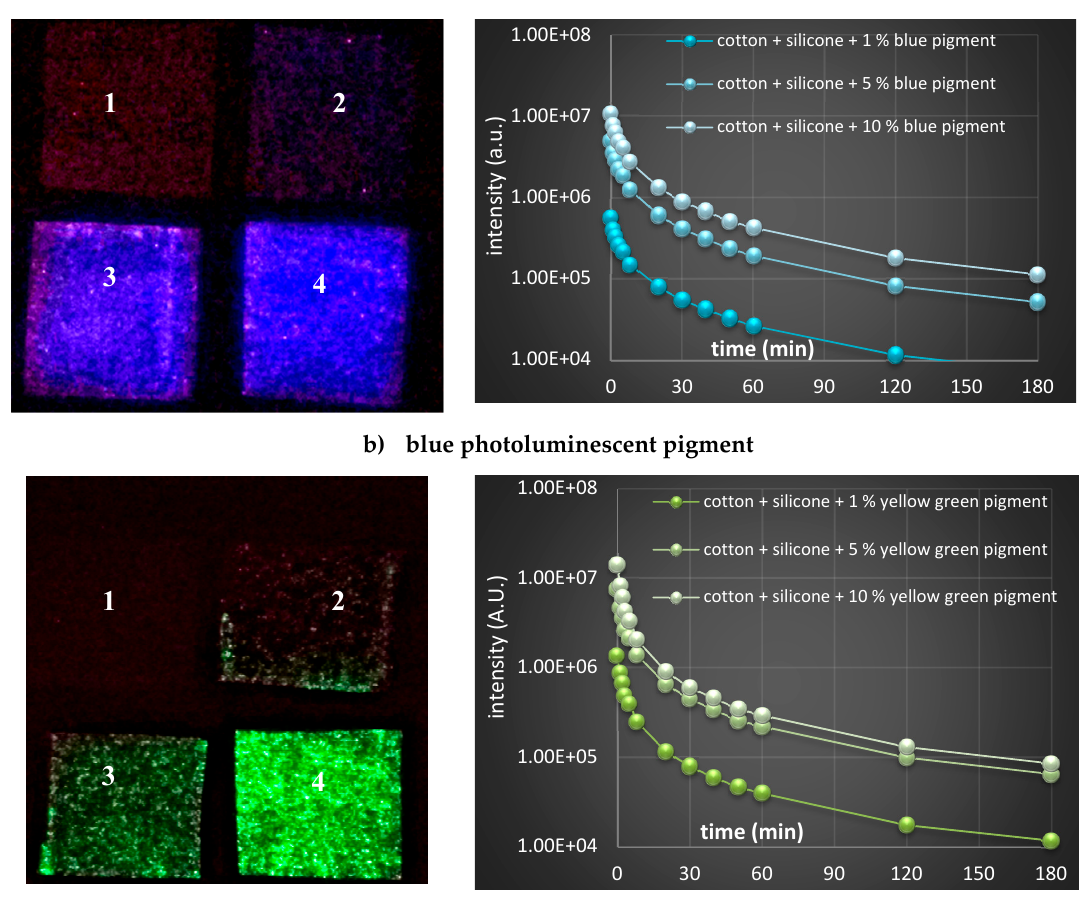
Figure 8. (left) Photographs depicturing differentially printed cotton fabrics, excited within a UV chamber (366 nm) for 5 min. Cotton printed with PDMS (1) 1 wt % (2), 5 wt % (3) and 10 wt % of violet ( a ), blue ( b ) and yellow-green photoluminescent pigment ( c ). (right) Luminescence decay curves were measured for the same samples in a 180 min period (after 1, 2, 3, 5, 8, 20, 30, 40, 50 60, 120 and 180 min). Luminescence curves for the cotton and cotton printed with PDMS without photoluminescent pigments are below the threshold value, i.e., luminescence of the microplate itself. Confocal microscopy was used for the investigation of the distribution of pigments in both the horizontal (xy) and vertical (xz/yz) directions of the cotton fabric, and the results were presented in Figure 9. Confocal microscopy permits depiction and localization of the fluorescing compounds unambiguously at light microscopy resolution [19], offering a non-destructive method for in-depth imaging, without demanding preparation steps. This is due to the point-by-point illumination of samples, and rejection of out of focus light, which enables the 3D imaging [39]. The 3D image is built up by sequential recording of fluorescence emission from a large number of points in a sample in all three dimensions, being achieved by controlled movement of the focus point of the laser beam by mirrors, and by moving the sample in the third dimension by automated stage [40]. The same imaging parameters were applied for both pigments and printed cotton fabrics. Under specified excitation conditions ( λ ex = 458nm), the particles can be visualised clearly and distinguished from the cotton fabric, which itself exhibited a very low background signal. The increase in pigment concentration from 1 up to 10 wt % was not supplemented by a fluorescence signal to a particular level (Supplementary data 1), as could also be observed in the fluorescence emission measurement. In general, the recipes for the printing of photoluminescent pigments on textile fabrics recommend suboptimal concentration of pigment, e.g. 30 wt %, which is higher than in our study, but increases